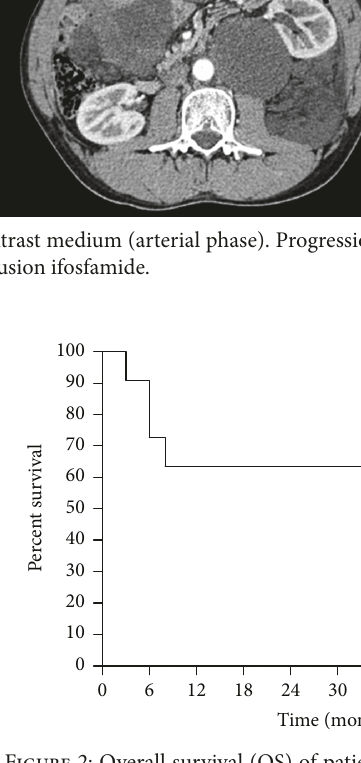
Figure 2: Overall survival (OS) of patients treated with high-dose prolonged-infusion ifosfamide chemotherapy (11 patients). Median OS was 37 months.